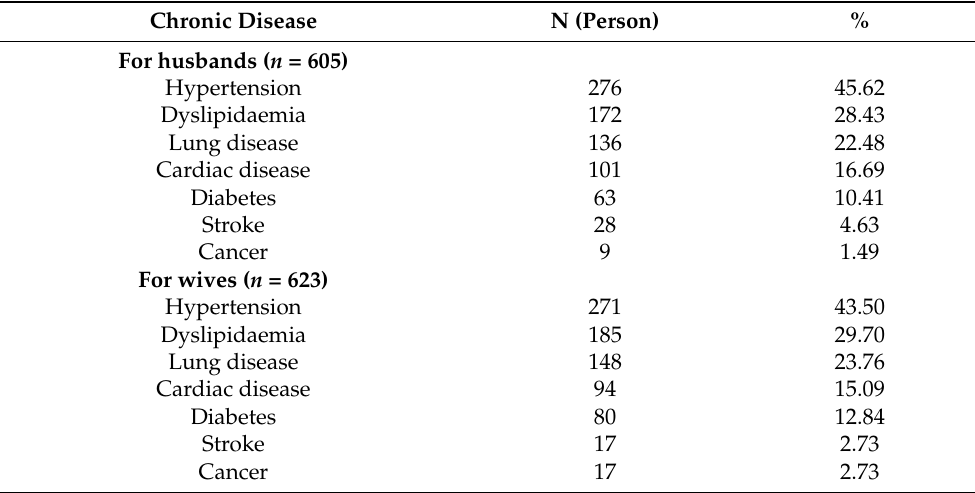
Table 3. Influence of spousal baseline chronic disease status on one’s chronic disease development over 4 years. Spousal Baseline Chronic Disease Status